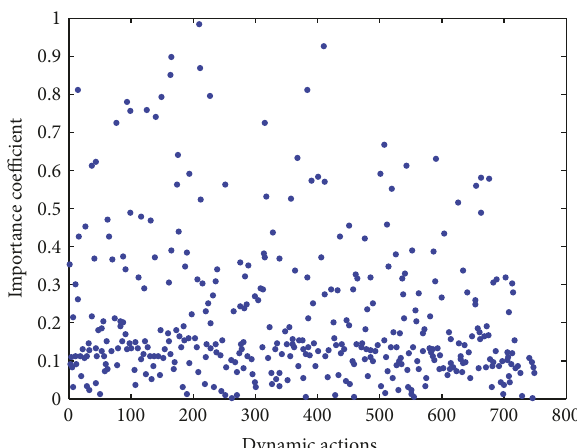
Figure 12: Importance coefficient of member 51 in various dynamic